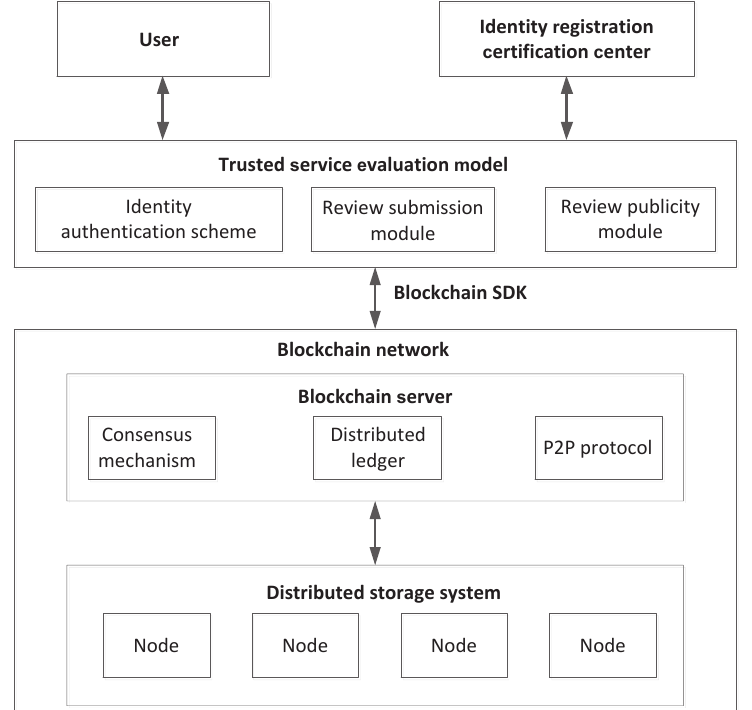
Fig. 5 Framework of the BCSE